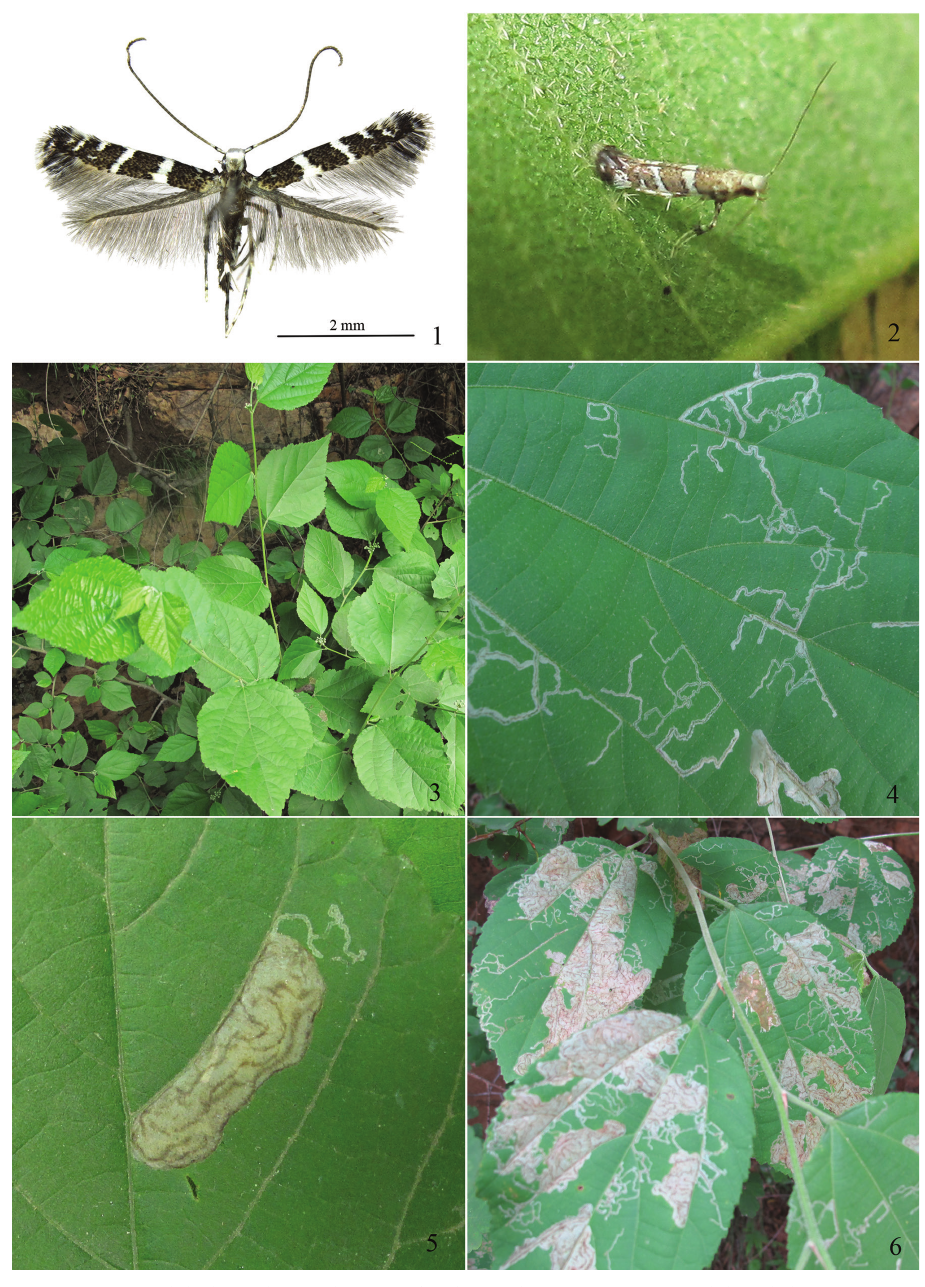
Figures 1−6. Adult, host plant and mines of Telamoptilia grewiae sp. n. 1 Adult in habitus, paratype 2 Live adult 3 Host plant 4 Linear mines by early instar larvae 5 Blotch mine by later instar larva 6 Seri- ously damaged leaves found in